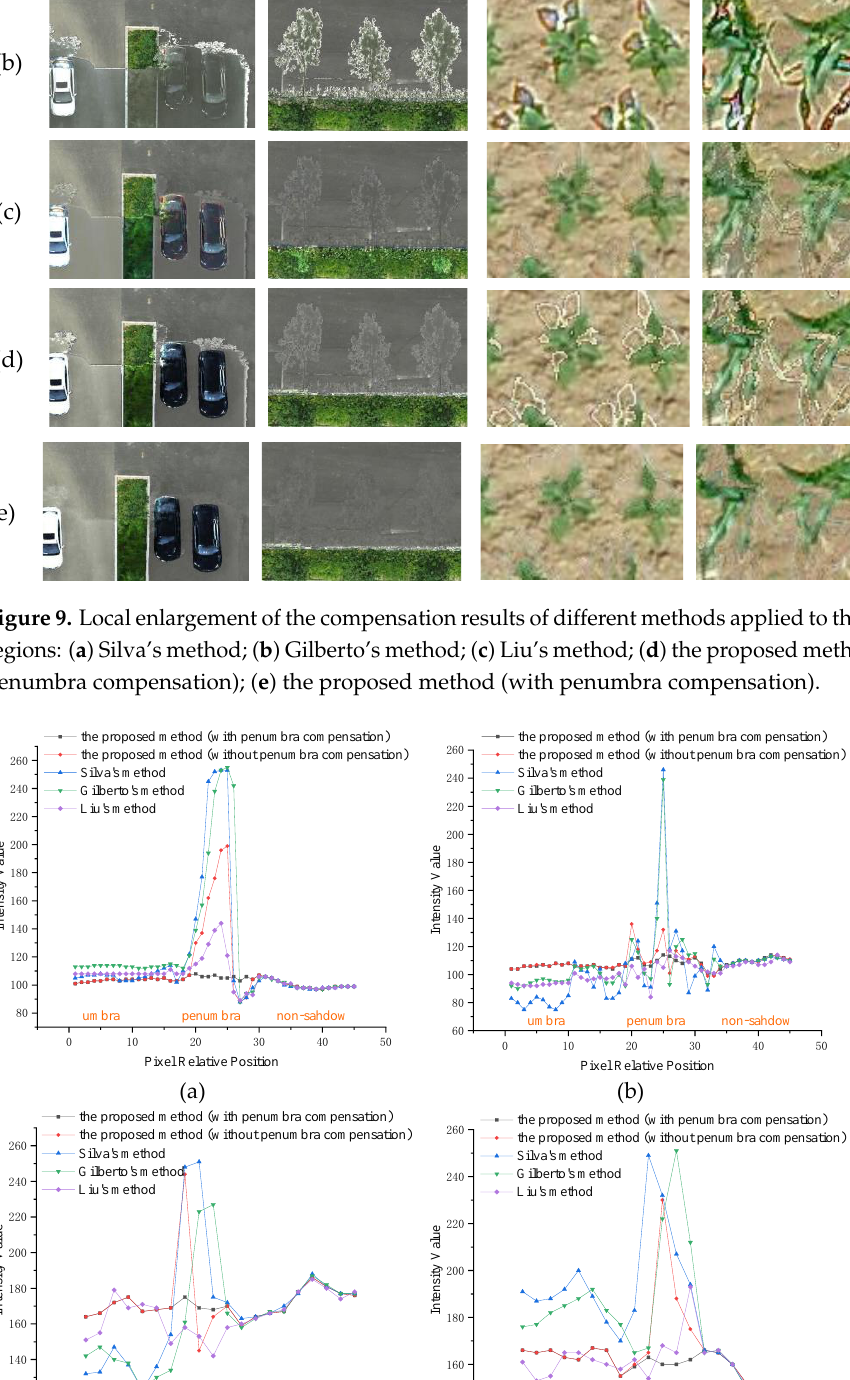
Figure 10. Profile analysis of the four detailed regions: (a) ROI1; (b) ROI2; (c) ROI3; (d) ROI4. Table 2. Quantitative evaluation results of color difference (CD).